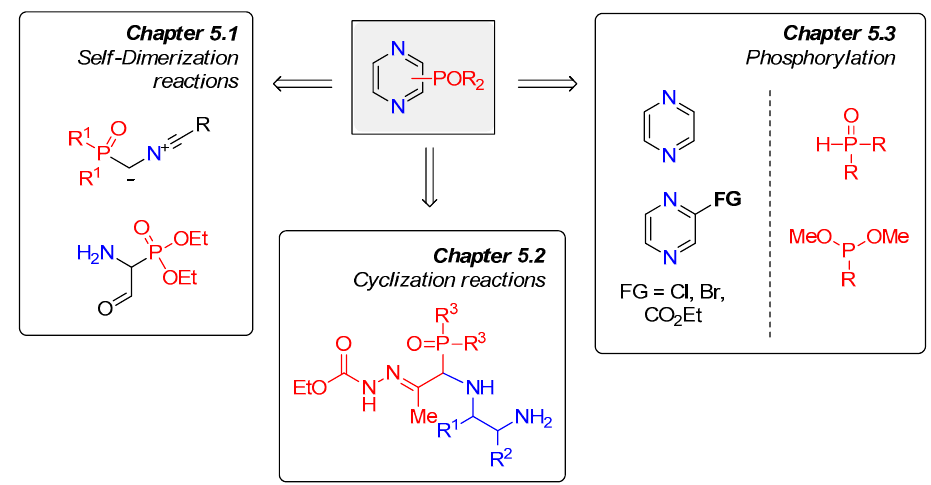
Figure 4. Approaches to synthesis of POR 2 -containing